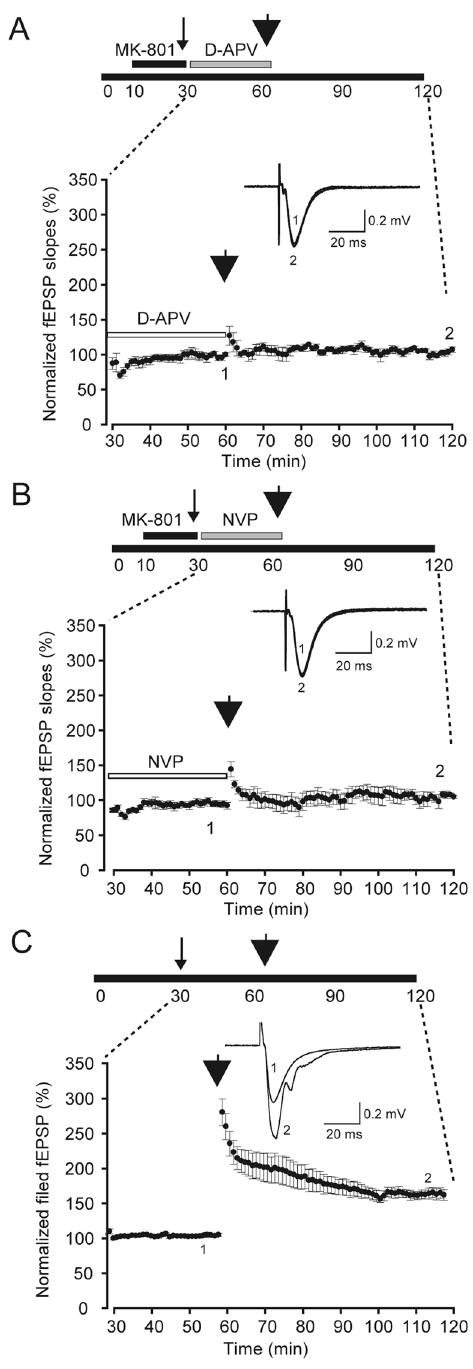
Figure 4. LTP induction in different situations. ( A ) Lack of LTP induction after obstruction of both S-NMDARs and ES-NMDARs (n = 4). D-APV was applied for 30 min after MK-801 was washed out. ( B ) Lack of LTP induction when the extrasynaptic NR2A subunit was blocked (n = 6). NVP-AAM077 (0.1 μ M) was applied for 30 min after MK-801 was washed out. ( C ) LTP induction after 5-Hz stimulation for 16 s (n = 11). Upper : Schematic diagram of the experiment protocol. Lower : The summary of normalized fEPSP slopes from the 30 th min to the 120 th min is provided. Inset : sample traces of EPSC at timings 1 and 2, as marked. Thin arrow heads indicate the time when the 16 s 5-Hz stimulation was delivered; thick arrow heads indicate the time when the three trains of HFS were